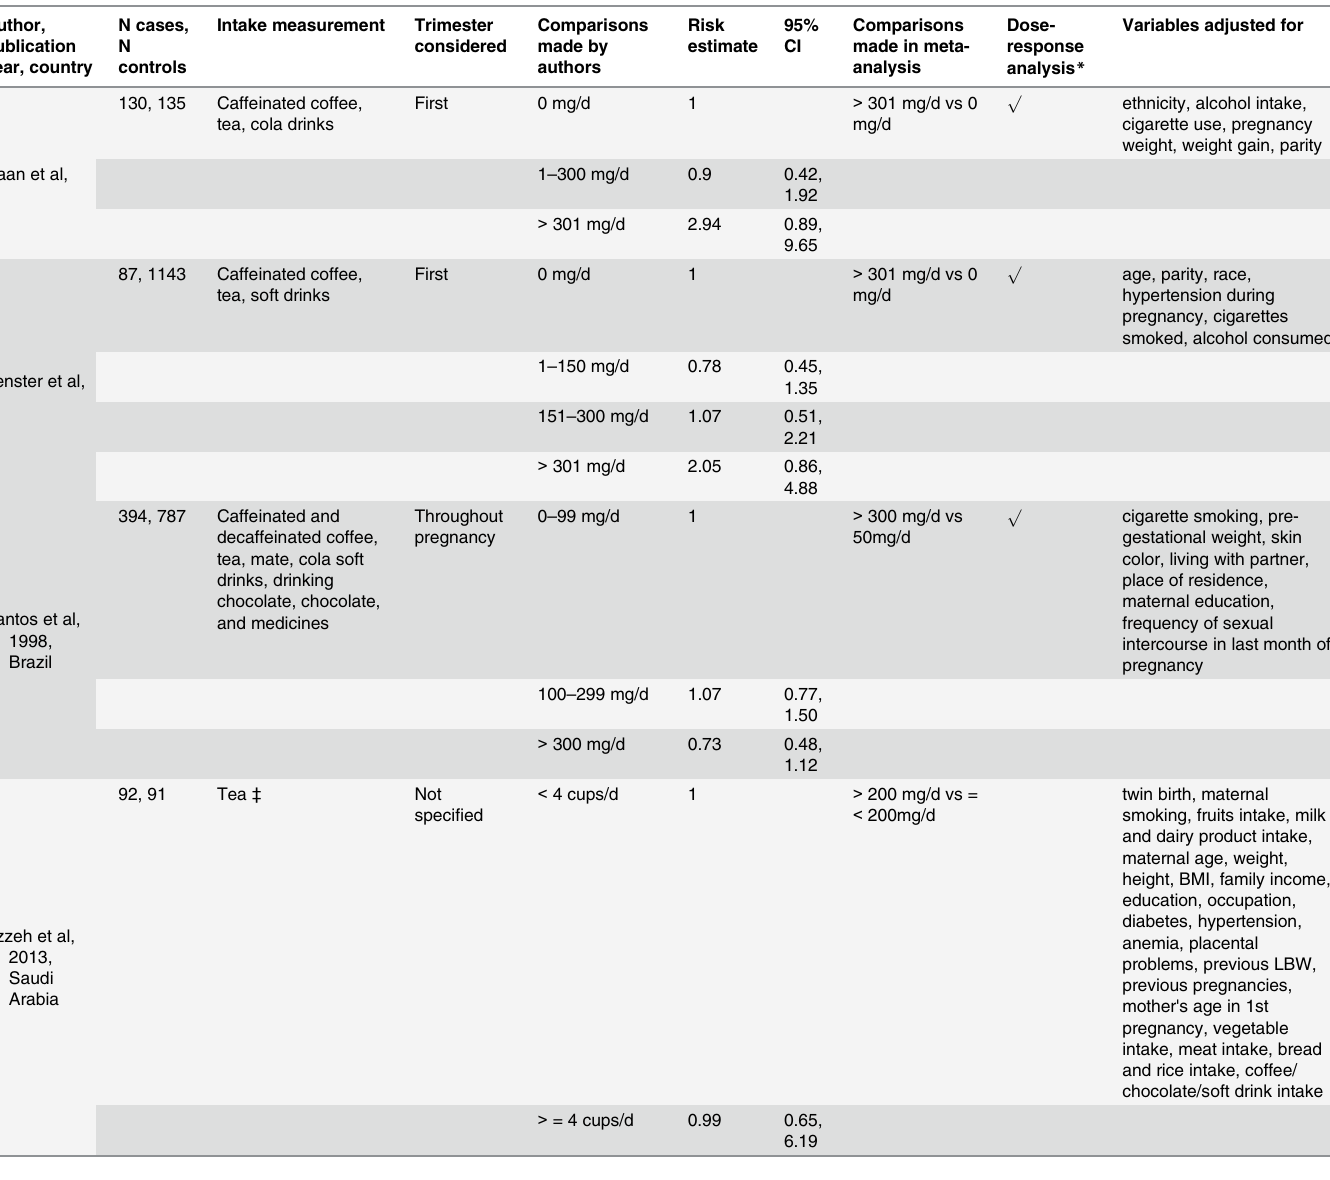
Table 2. Case-control studies of caffeine consumption and risk of low birth